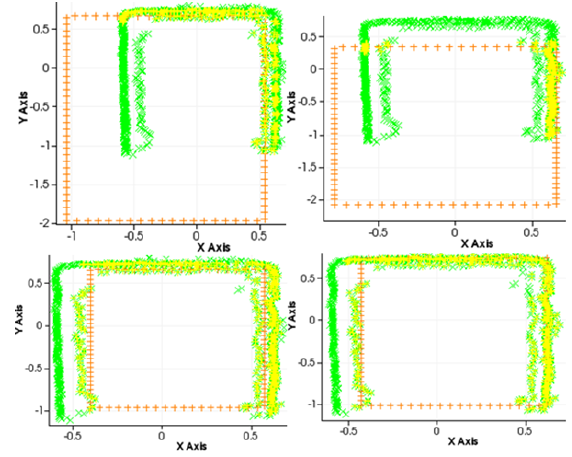
Figure 7: Intra class model selection using the simple rectangular template. The upper row depicts two samples (the brown pluses) of a rectangular template of Type-2 from Table 1 while the